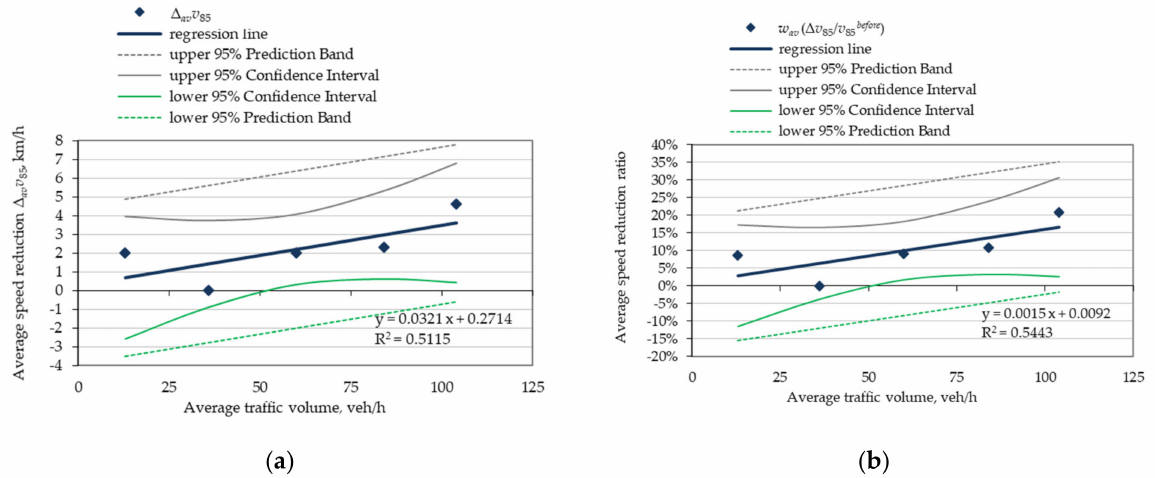
Figure 13. Regression analyses (testing ground No. 1) for the following relationships: ( a ) average reduction in free-flow speed ∆ v 85 and average traffic volume ( R = 0.72); ( b ) speed reduction ratio and average traffic volume ( R = 0.74). Source: own work of the author.